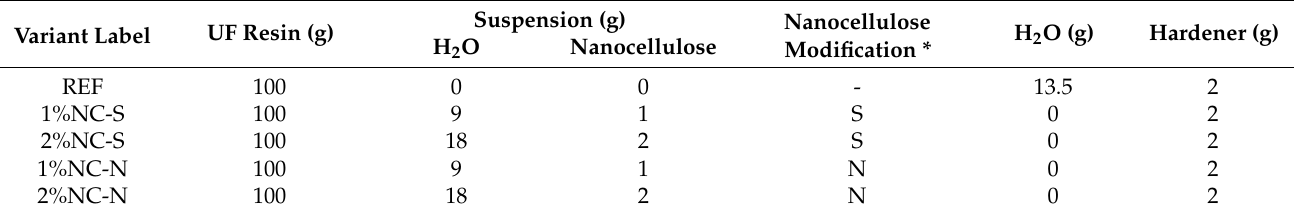
Table 2. The compositions of adhesive